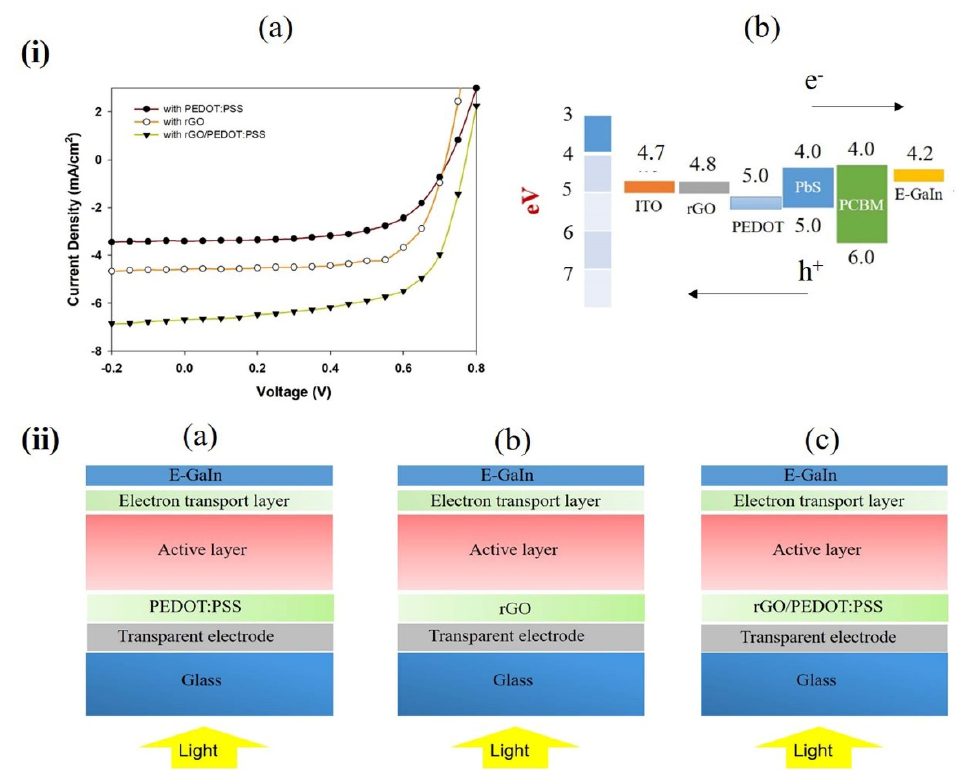
Figure 3. ( i ) ( a ) Current density-voltage curve of photovoltaic devices based on different hole transport layers and ( b ) the energy level alignment of devices with PEDOT:PSS as the HTL and rGO as the buffer layer. ( ii ) Device structure ( a ) ITO/PEDOT:PSS/PbS:PCBM/E-GaIn, ( b ) ITO/rGO/PbS:PCBM/E-GaIn, ( c ) ITO/rGO/PEDOT:PSS/PbS:PCBM/E-GaIn. Table 1. Device parameters as open-circuit voltage (V oc ), short-circuit current density (J sc ), fill factor (FF) and power conversion efficiency (PCE) from J-V characteristics for different hole transport layers; with PEDOT:PSS, rGO and rGO/PEDOT:PSS under A.M 1.5G illumination at 100 mW/cm 2